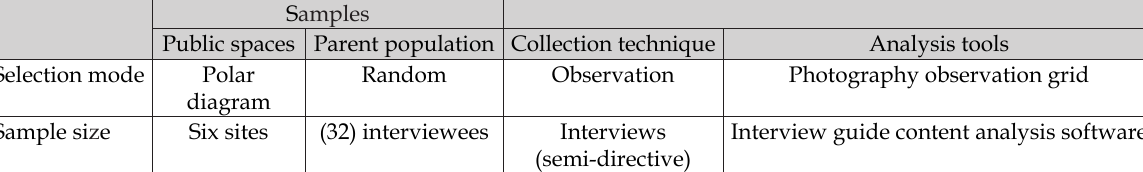
Table 1. Summary of the methodological